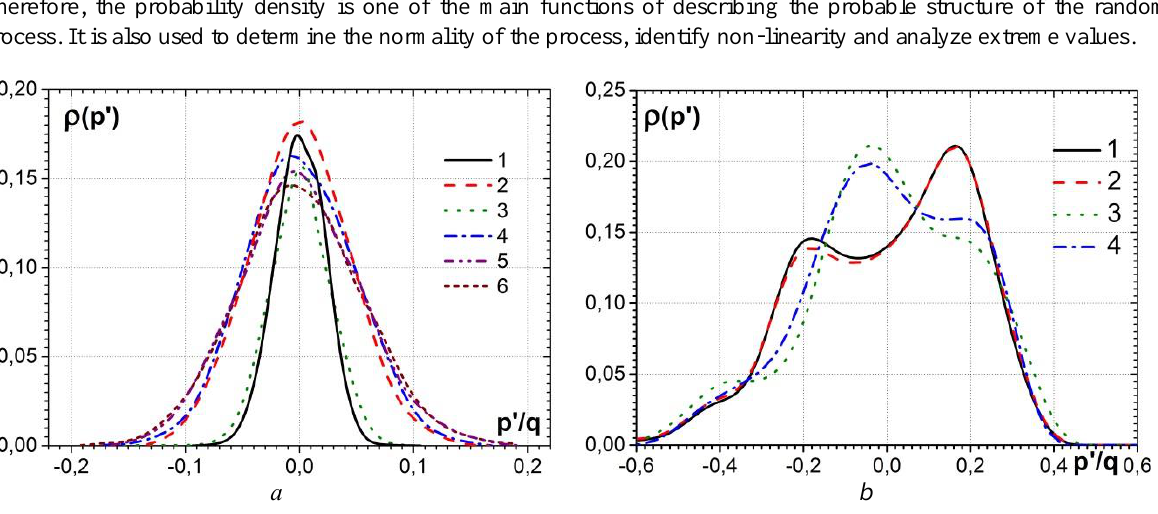
Figure 5. Probability density functions of the pressure fluctuations: stationary (a) and pulsating fluid flow (b) The probability density functions of the pressure fluctuations near the side jet of the open and semi-closed valve, through which the steady and pulsating stream flows, are calculated according to dependence (3) and shown in Figure 5. Curve 1 in Figure 5a presents the results of measurements of the pressure fluctuations near the side jet of the pure water flow with flow rate of 15 l/min through the open valve. Curve 2 is obtained for the same research conditions, but for the semi-closed valve. Curves 3-6 were measured for the steady flow of the glycerol solution of different concentrations. Thus, curve 3 was measured near the side jet of the open valve, through which flowed the solution of 43% glycerol and 57% water. Curve 4 was measured for the semi-closed valve and 35% glycerol in the aqueous solution, curve 5 - 38% glycerol and curve 6 - 43% glycerol. Figure 5b shows the results of measurements of the hydrodynamic noise near the side jet of the pulsating flow of the pure water with a frequency ( f ) of 1 Hz or 60 beats per minute. Curves 1, 2 were measured for the open valve conditions, and curves 3, 4 were measured for the semi-closed valve conditions. Curve 1 was measured at the distance equal to the diameter ( d ) of the valve, curve 2 was measured at the distance x =1.2 d , curve 3 was measured at the distance x = d , and curve 4 was measured at